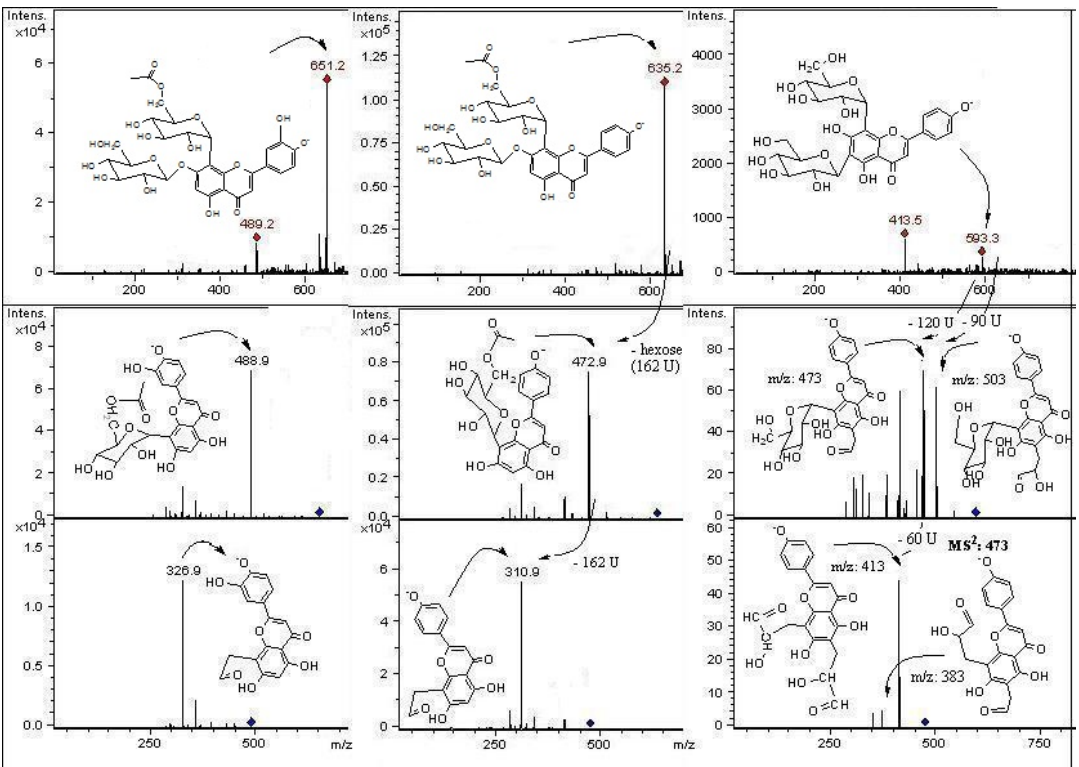
Figure 7. Structures, fragmentation, full ESI-MS and MS-MS spectra of peaks 18, 20, and